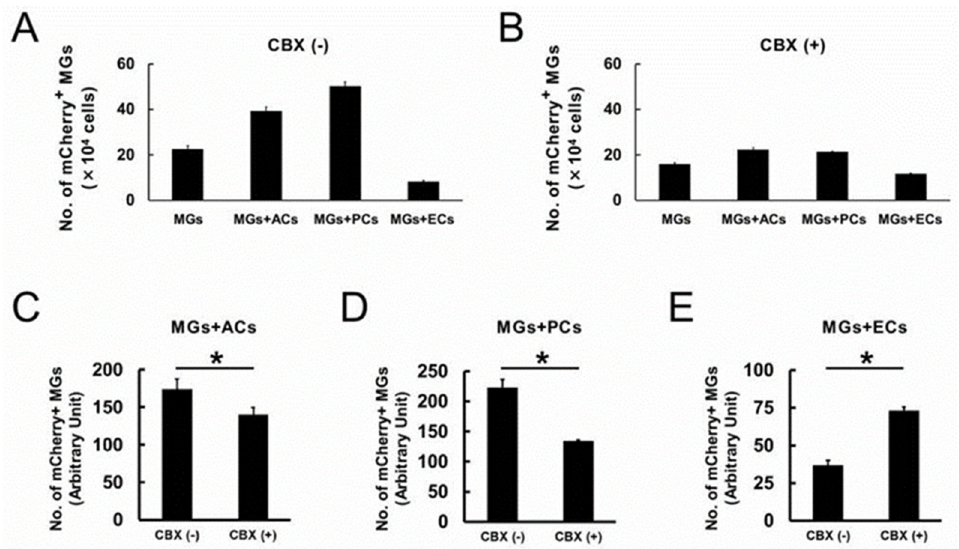
Figure 9. Number of mCherry + MGs after incubation without CBX ( A ) or with CBX ( B ) (( A , B ); n = 3 for each group). The number of mCherry + MGs was analyzed for MGs coincubated with ACs ( C ), PCs ( D ), or ECs ( E ) between the CBX( − ) and CBX(+) groups. The results show that the presence of CBX significantly reduced the number of MGs coincubated with ACs ( C ) or PCs ( D ), but it significantly increased that of MGs coincubated with ECs ( E ). Statistical analysis was performed using the Student’s t -test (( C – E ); n = 3 for each group). * p < 0.05 between the CBX ( − ) and CBX (+)